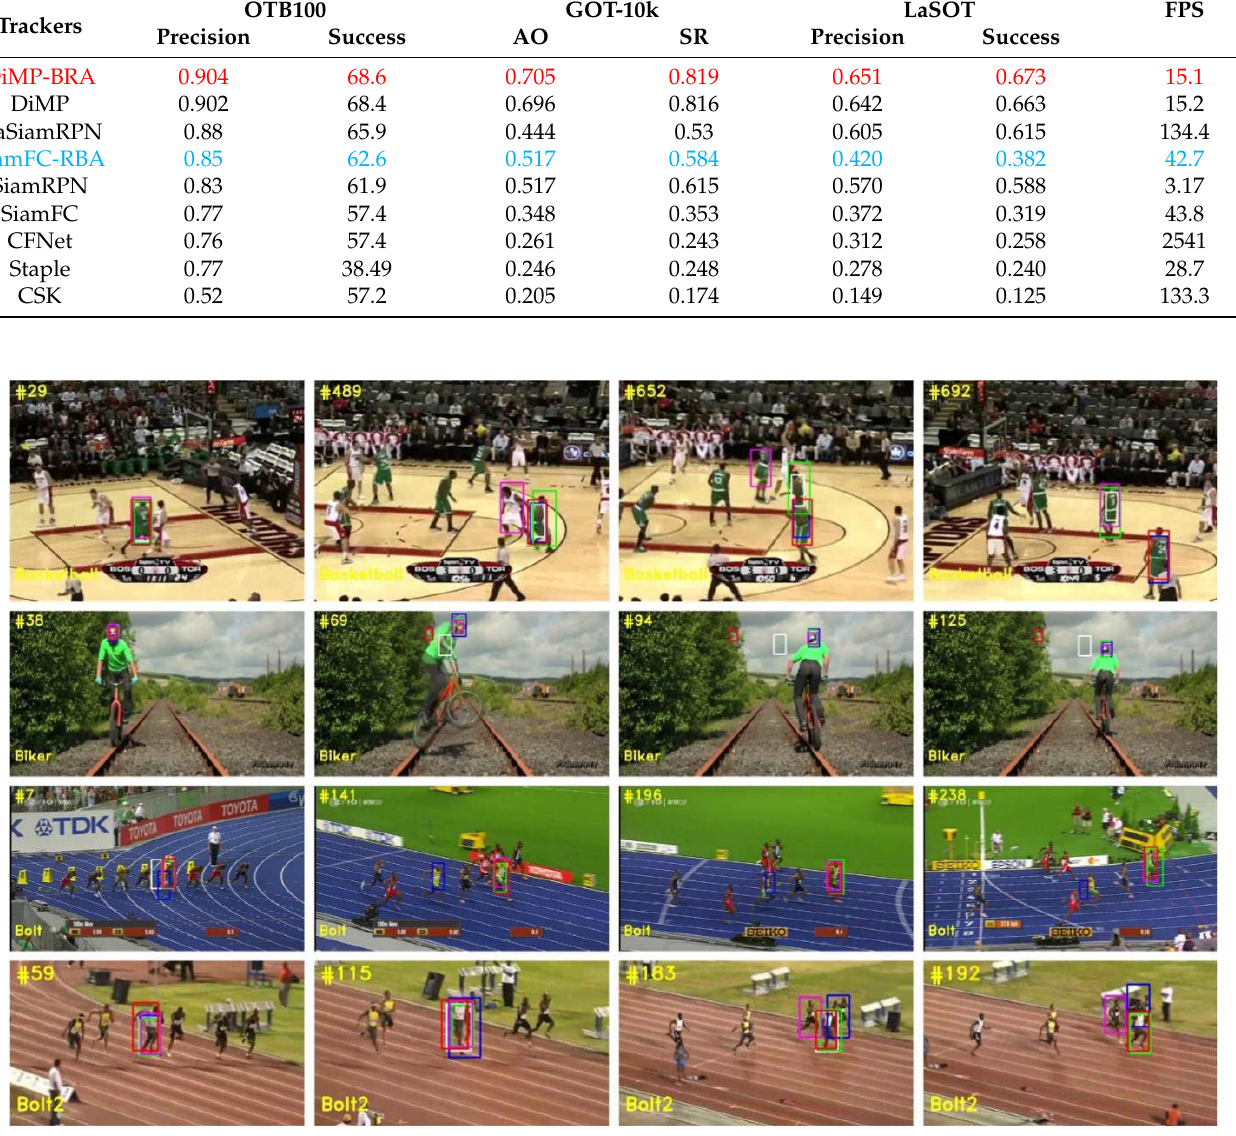
Figure 13. Human tracking with similar objects online in real time.